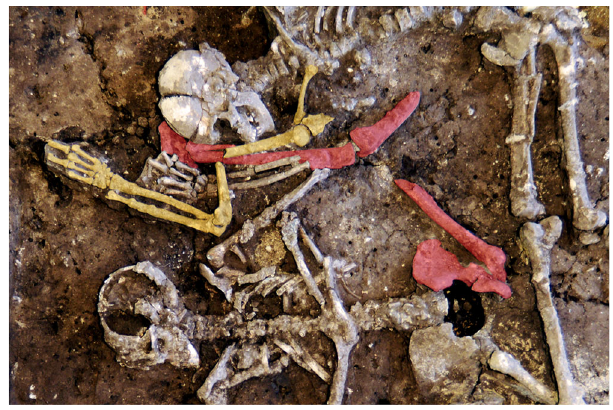
Fig. 5 Examples of aberrant positioning of perimortem fractured limbs. In situ positions of the perimortem fractured right upper limb in ind. 6 (humerus; yellow) and right lower limb in ind. 7 (femur;